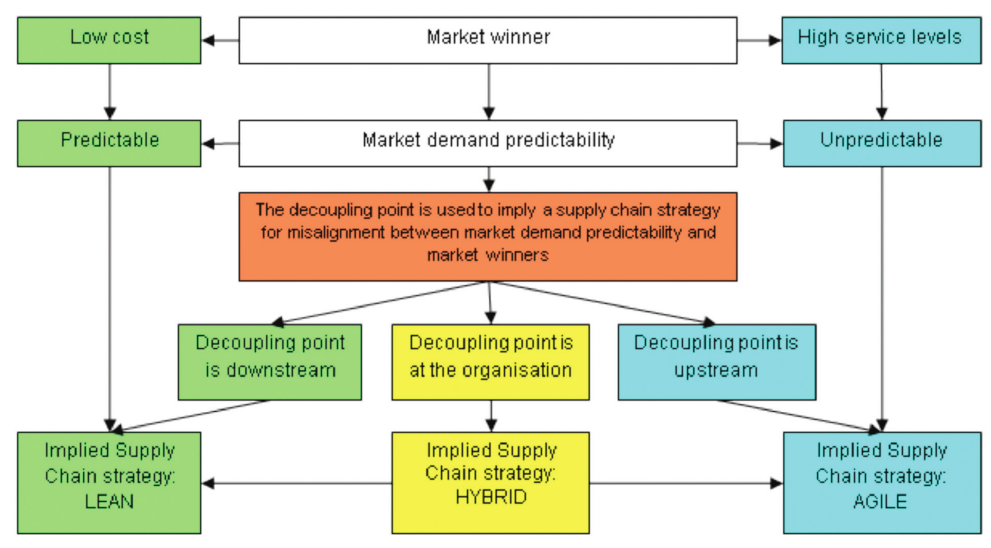
Figure 1: Suggested supply chain strategy based on market demand predictability, market winner and decoupling